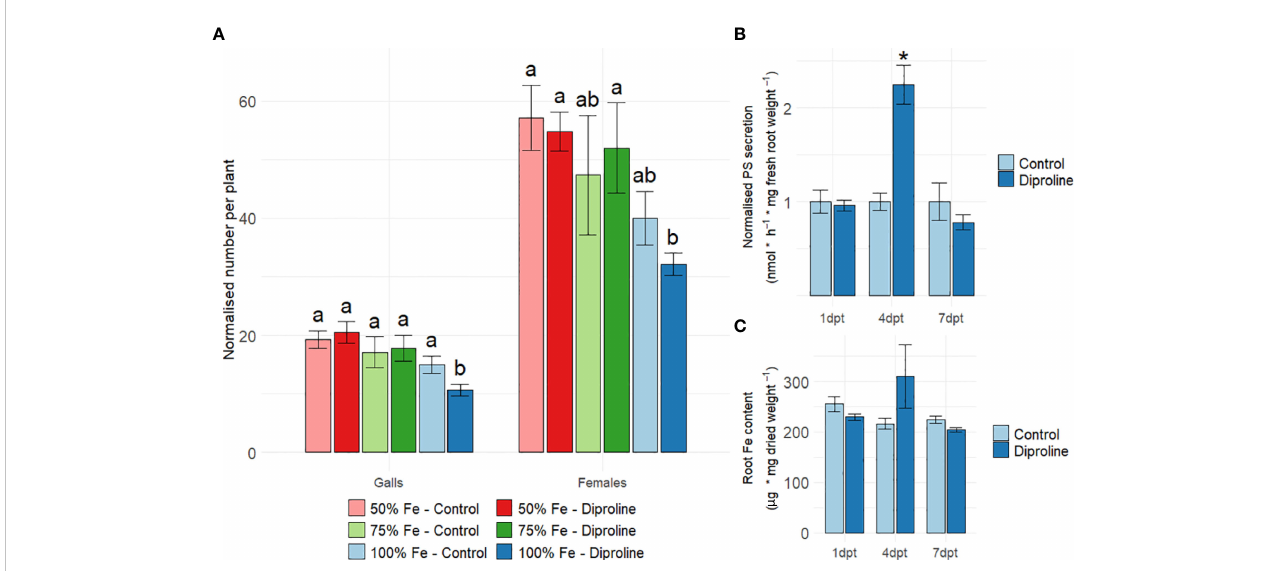
FIGURE 2 Diproline-induced resistance in rice is dependent on Fe supply. (A) Normalized number of galls and nematodes per plant, as assessed fourteen days after inoculation with 250 Meloidogyne graminicola second-stage juvenile nematodes. One day before inoculation, fourteen-days-old rice shoots were treated with water (control) or 500 µM diproline. During the entire experiment, plants were supplied with different levels of Fe, expressed relative to the optimal concentration of 75 µM (i.e. 100%) (n = 16). (B) Normalized phytosiderophore (PS) levels in root exudates after foliar treatment with water (control) or 500 µM diproline (n = 4). (C) Intracellular root Fe levels after foliar treatment with water (control) or 500 µM diproline (n = 3). (B, C) Plants were grown under optimal Fe supply and were uninoculated for the PS and Fe quanti fi cations. Error bars represent the standard error of the mean. (A – C) Asterisks indicate signi fi cant differences upon comparison of diproline-treated plants with same-aged, mock-treated control plants. In subpanel a, treatments with different letters are signi fi cantly different (p < 0.05), according to the ANOVA and a post-hoc Duncan ’ s new multiple range test. In subpanels, b and c, asterisks indicate a signi fi cant difference from mock-treated plants according to a two-sided heteroscedastic t-test